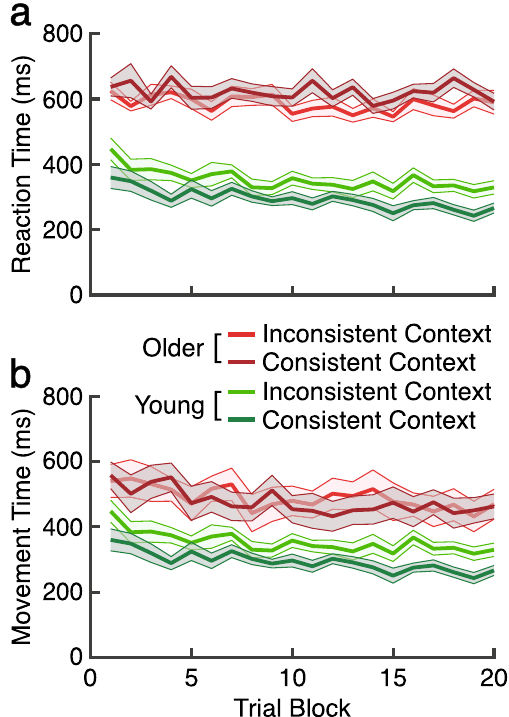
Figure 5. Reaction time and movement time during re-learning for the single and dual-task groups in young and older adults. Young and older groups are represented in green and red, respectively. Within each age group, the single-task and dual-task groups are represented by the dark and light-colored lines, respectively. Ribbons indicate SE. ( a ) Reaction time. ( b ) Movement